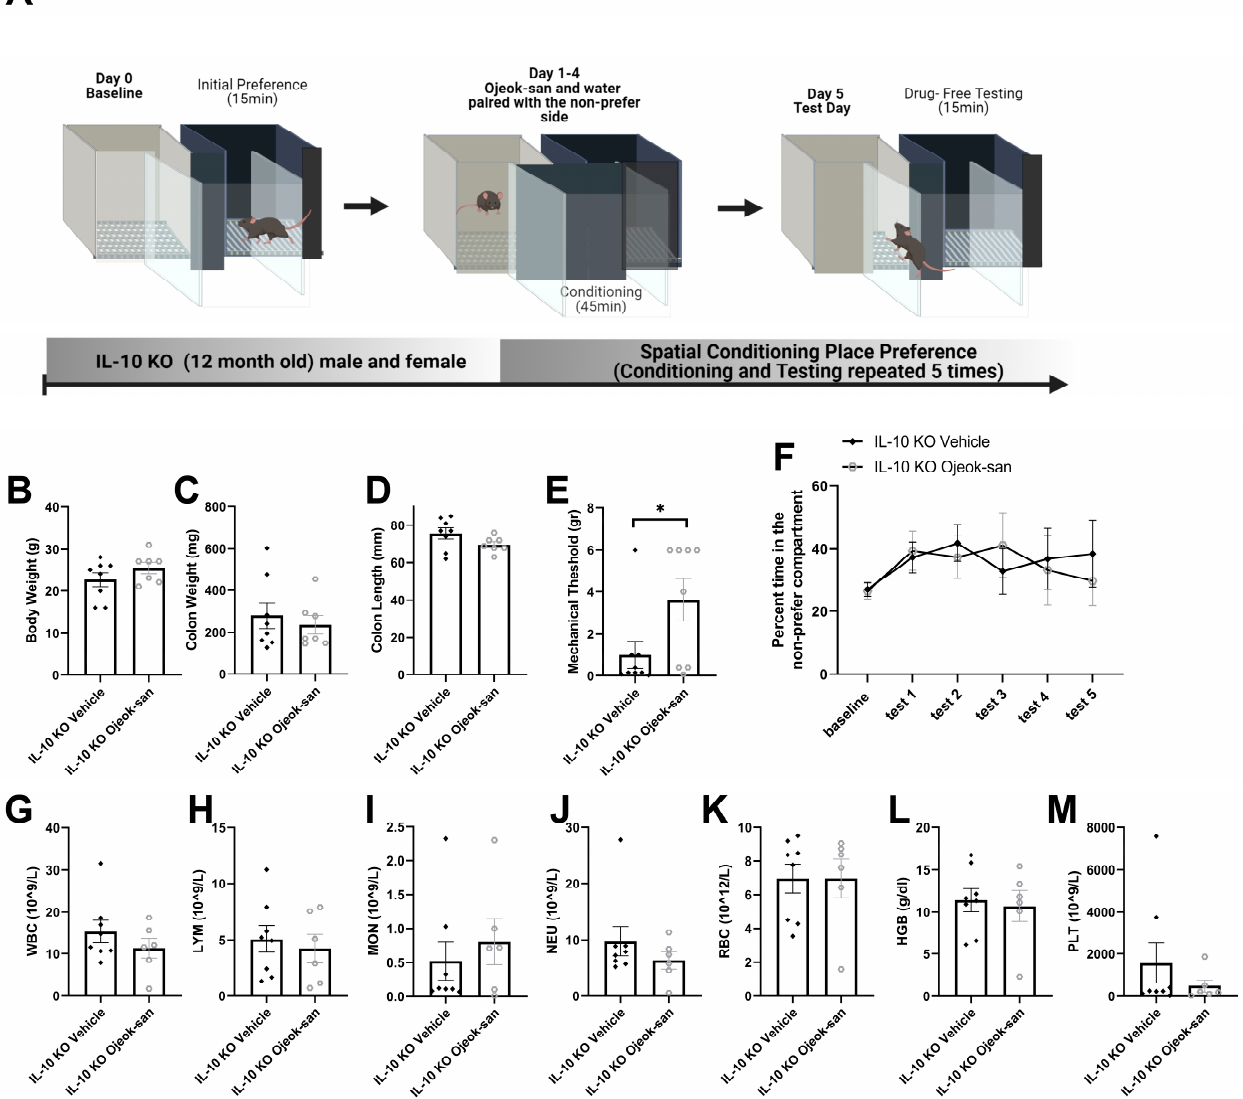
Figure 7. Five-week administration of OJS does not impact disease progression, but improves mechanical hyperalgesia, without promoting reward-seeking behavior in the IL-10 KO mouse model of spontaneous colitis. ( A ) A graphical depiction of spatial conditioning place-preference protocol, ( B ) body weight, ( C ) colon length, ( D ) colon weight, ( E ) mechanical threshold to stimuli with von Frey filaments, ( F ) percentage of time spent on the OJS-paired side compartment during the test sessions, ( G ) WBC, ( H ) LYM, ( I ) MON, ( J ) NEU, ( K ) RBC, ( L ) HGB, and ( M ) PLT in vehicle- and OJS-treated IL-10 KO mice. Values are represented as mean ± SEM; n = 8–9 mice per group. Two-way RM AVOVA was conducted for F. Two-tail unpaired t -test was conducted for ( B – E ), and ( G – M ). * Indicates statistical significance between groups, p < 0.05.